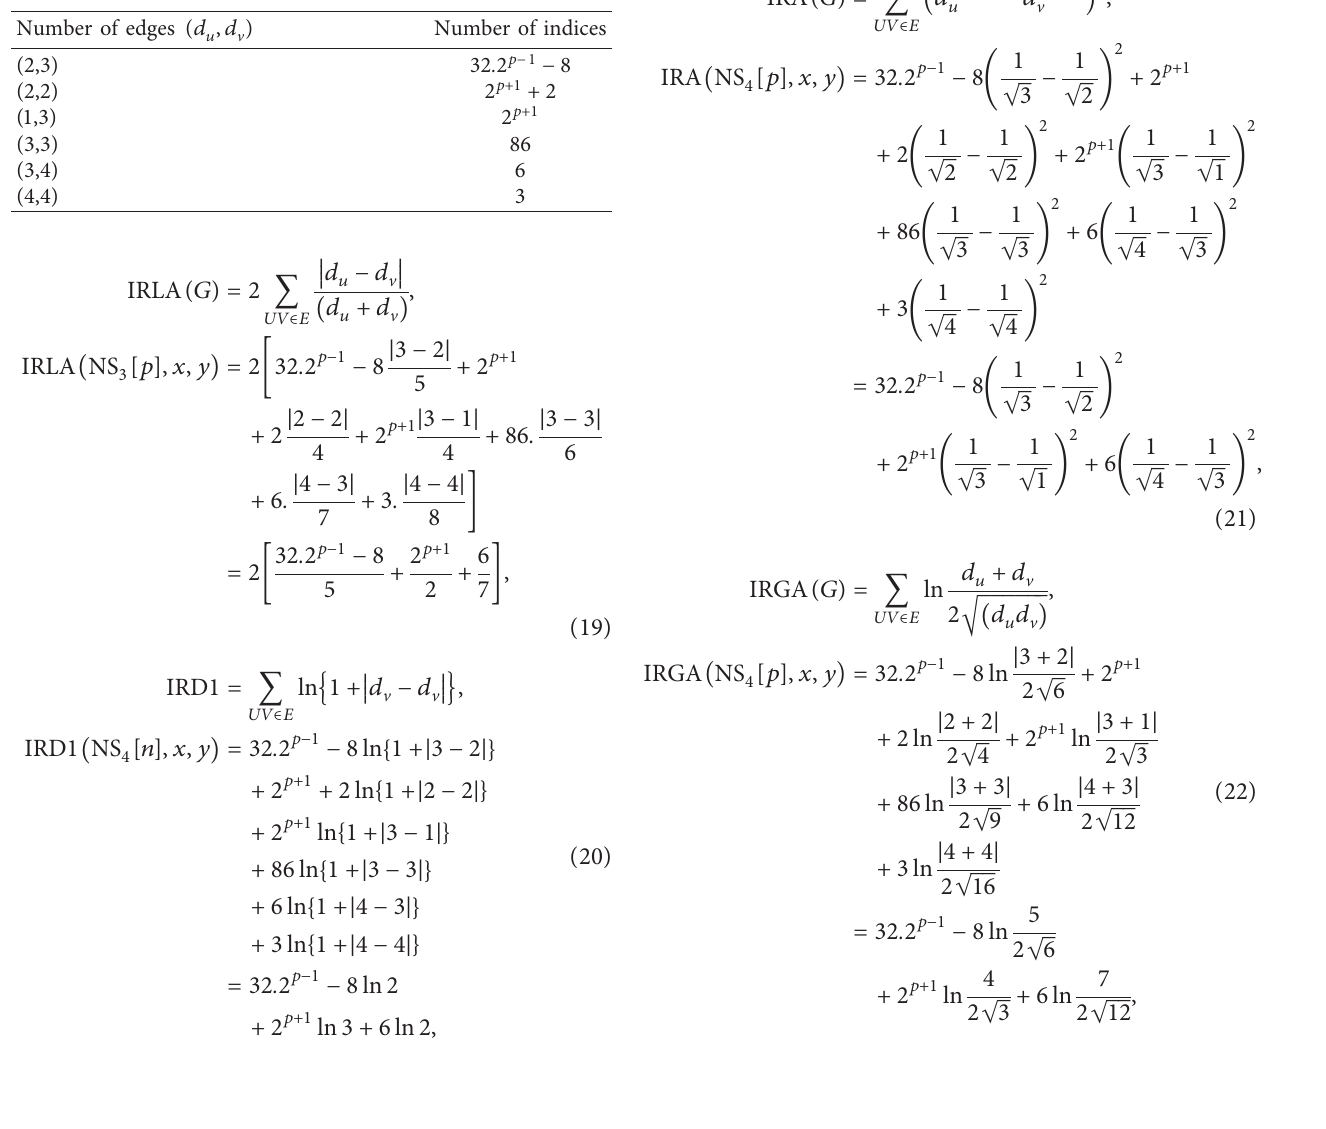
Table 3: Edge partition of fullerene